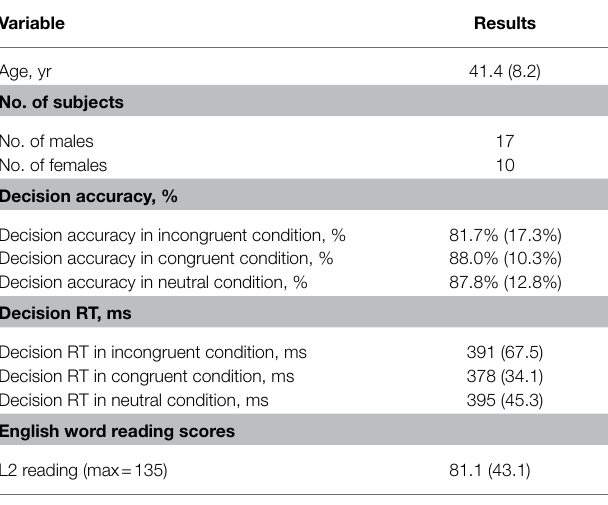
TABLE 1 | Demographic characteristics and behavioral